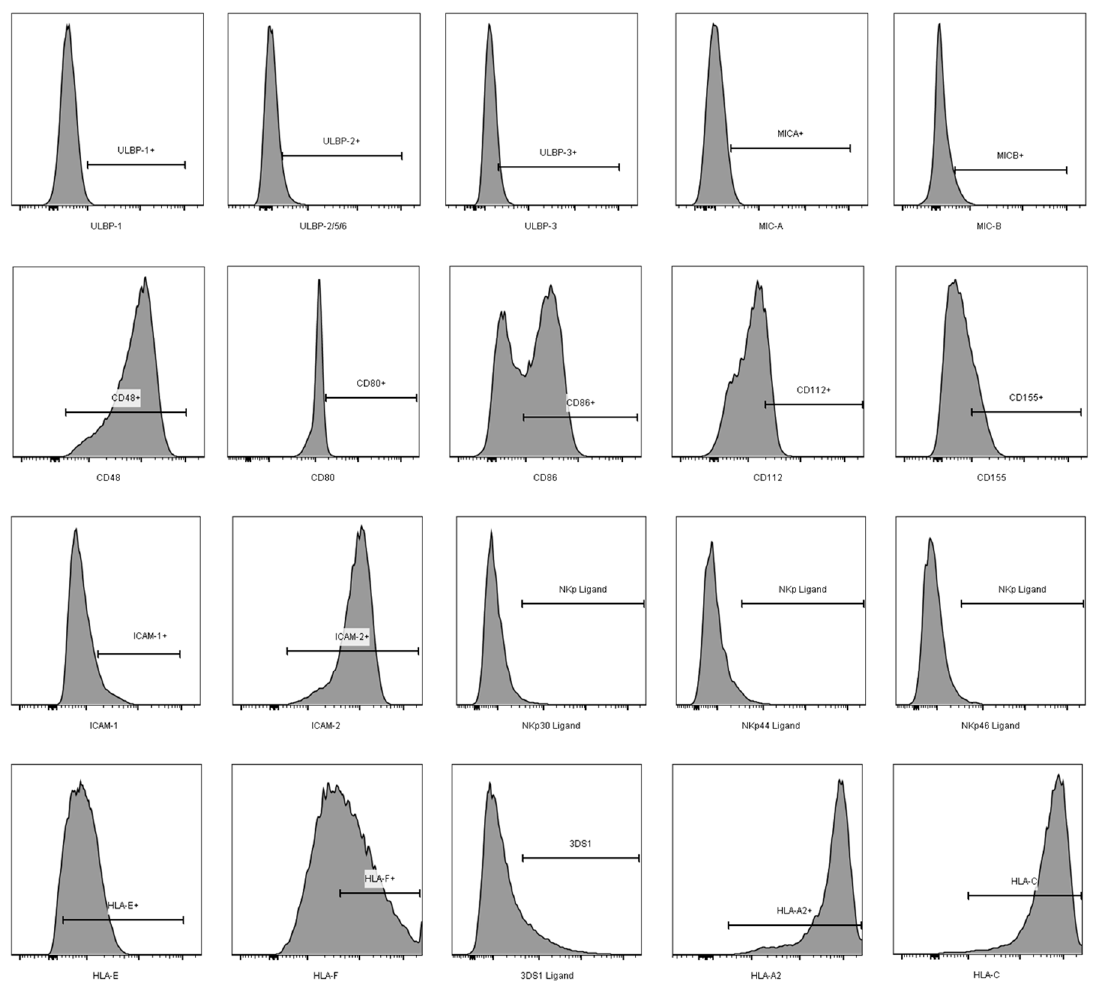
Figure 2. Histograms showing sample flow cytometry profiles for the ligands studied. Bars in each plot indicate the population expressing each aNKR, Gates were set using Unstained, single stained controls, fluorescence minus one, and secondary antibody alone controls.